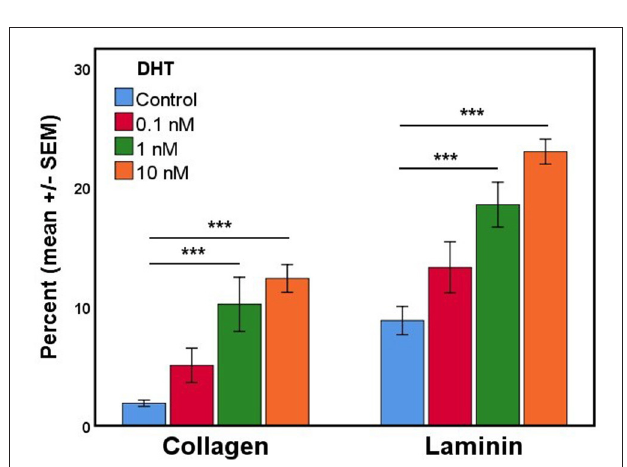
FIGURE 5 | Muscle cell morphology was assessed in vitro with fetal gubernacula immobilized in Matrigel to allow peripheral migration of myoblasts and subsequent formation of striated muscle fibers. Using this model, we found no differences in muscle cell morphology between LE/wt samples exposed ( n = 10) and unexposed ( n = 10) to 10nM DHT and unexposed LE/orl ( n = 19) fetal gubernaculum cells following cell migration and muscle fiber formation (results expressed using a logarithmic scale; area in µ m 2 ; aspect and length in µ m).